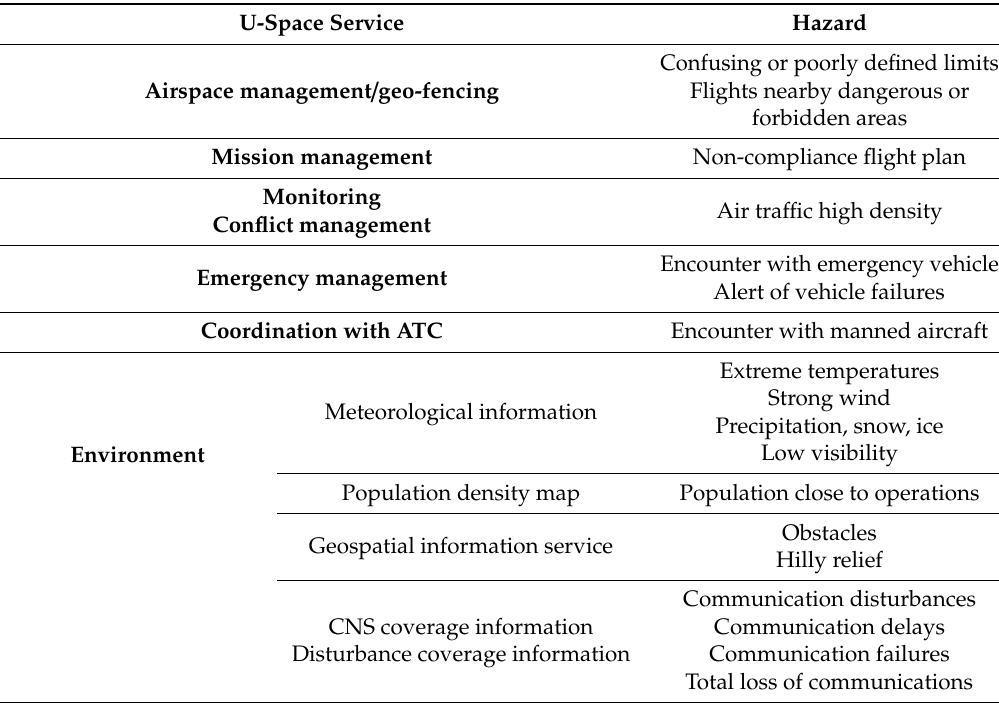
Table 9. Hazards related to U-space